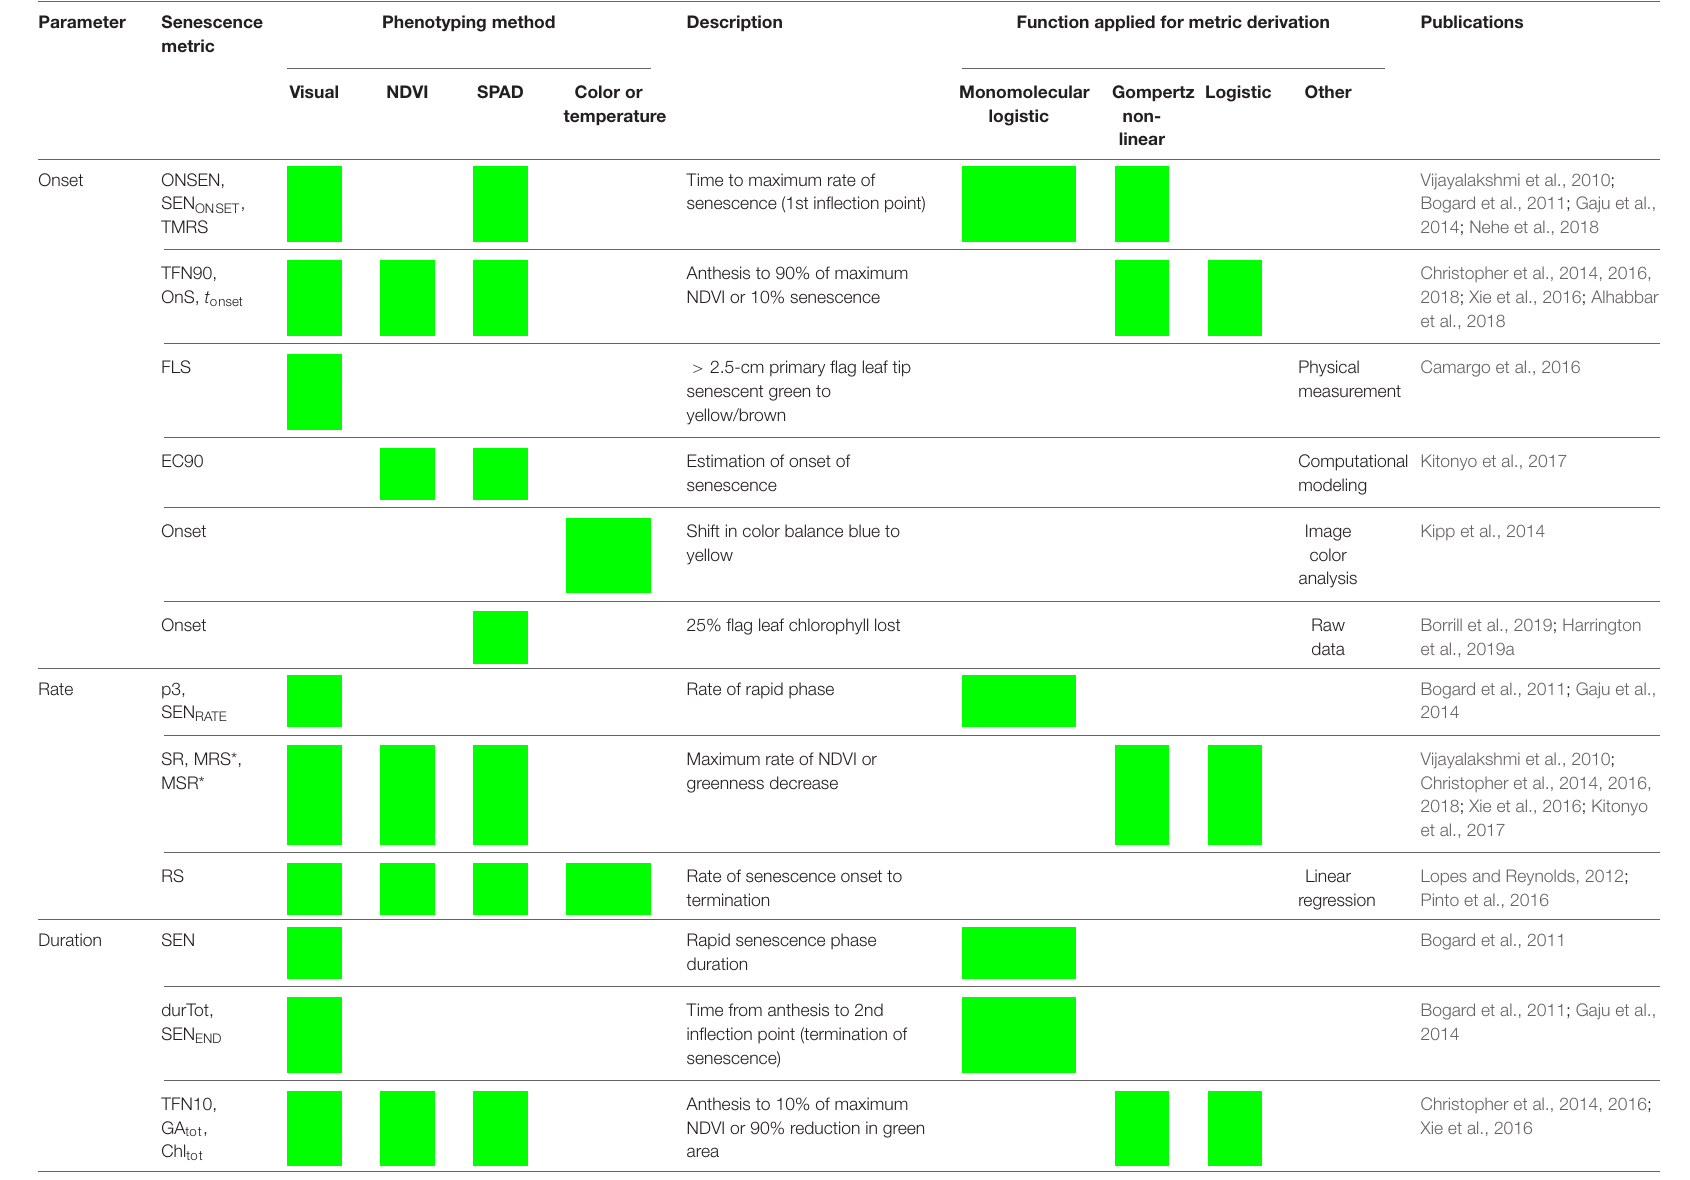
TABLE 1 | Reviewing methods used to score, quantify, and describe leaf senescence progression. Senescence phenotyping concerns monitoring changes in greenness over time for which multiple methods can be used. To characterize, compare, and quantify senescence phenotypes, time course senescence data can be transformed into a series of parameters ( Figure 2 ) using a variety of